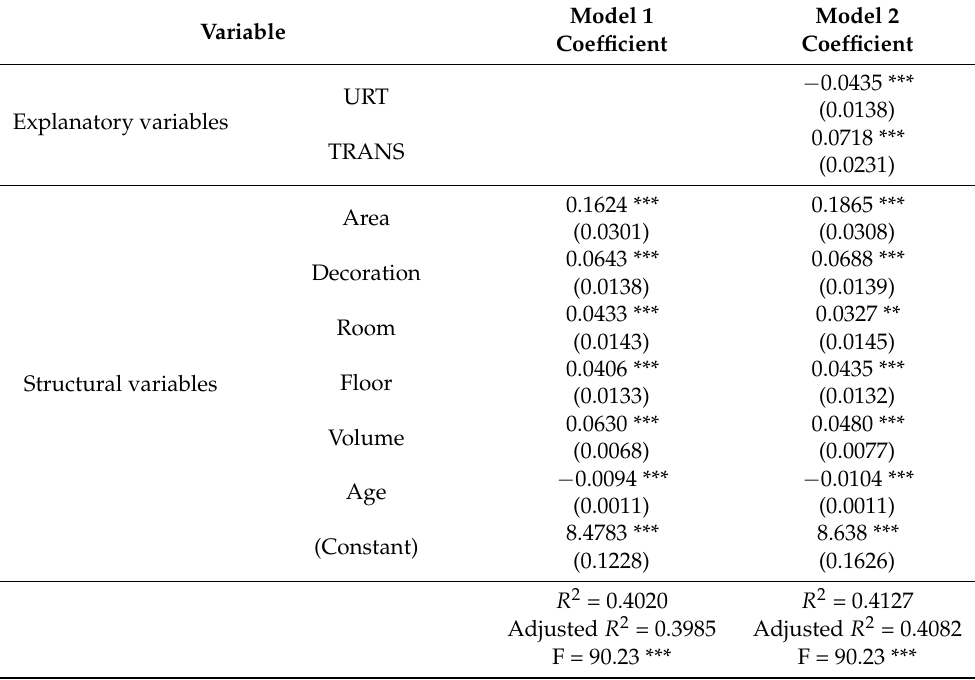
Table 2. The results of the effect of URT on residential property